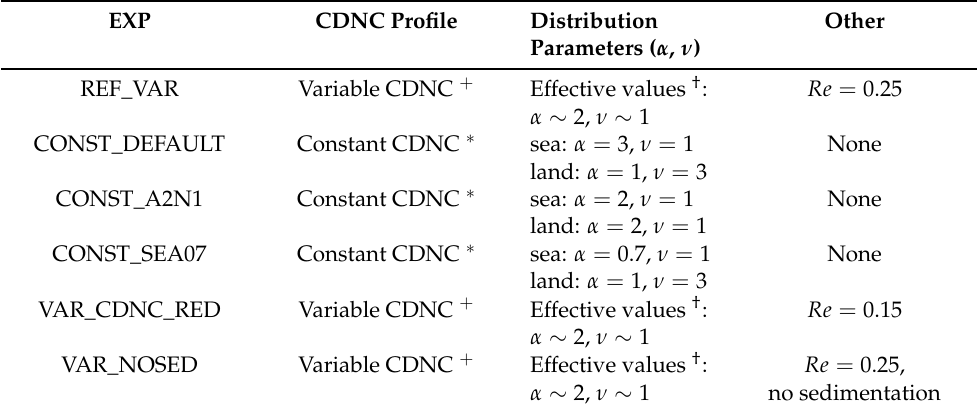
Table 1. Description of the HARMONIE-AROME cycle 43h2.2